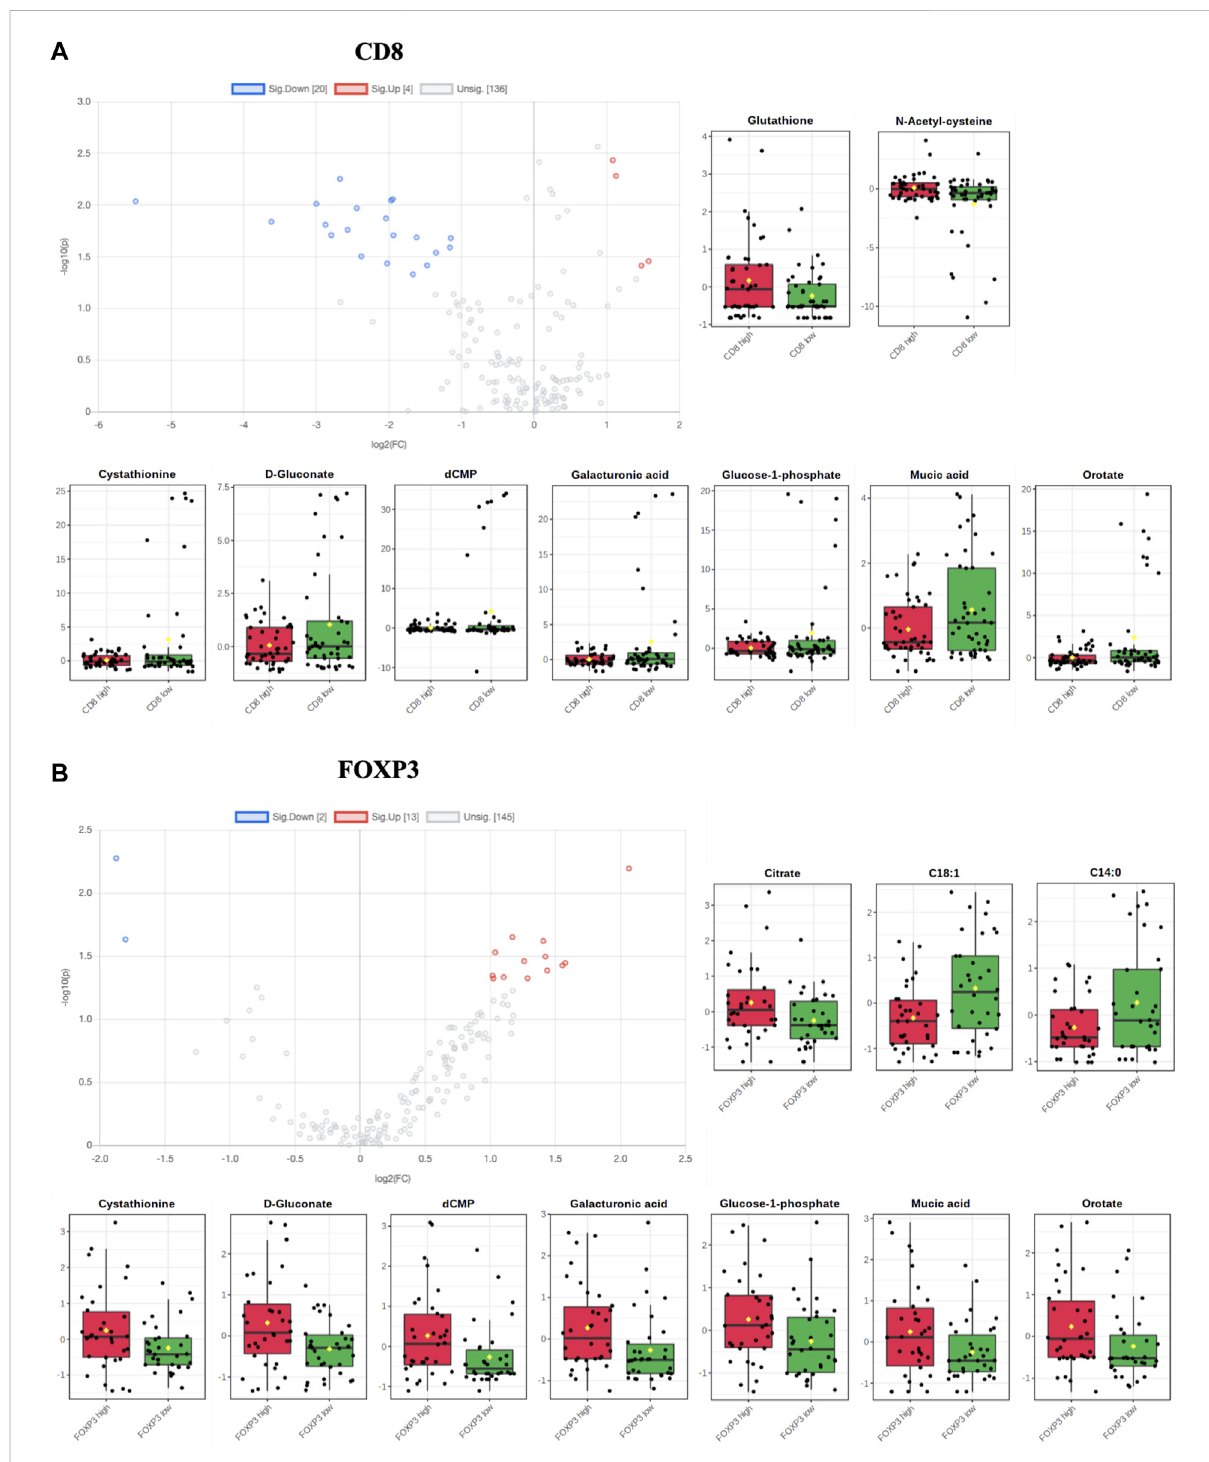
FIGURE 5 (A,B) Volcano plots and single metabolite enrichment representation for both CD8 and FOXP3 enriched ROIs (signi fi cant values have p < 0.05).